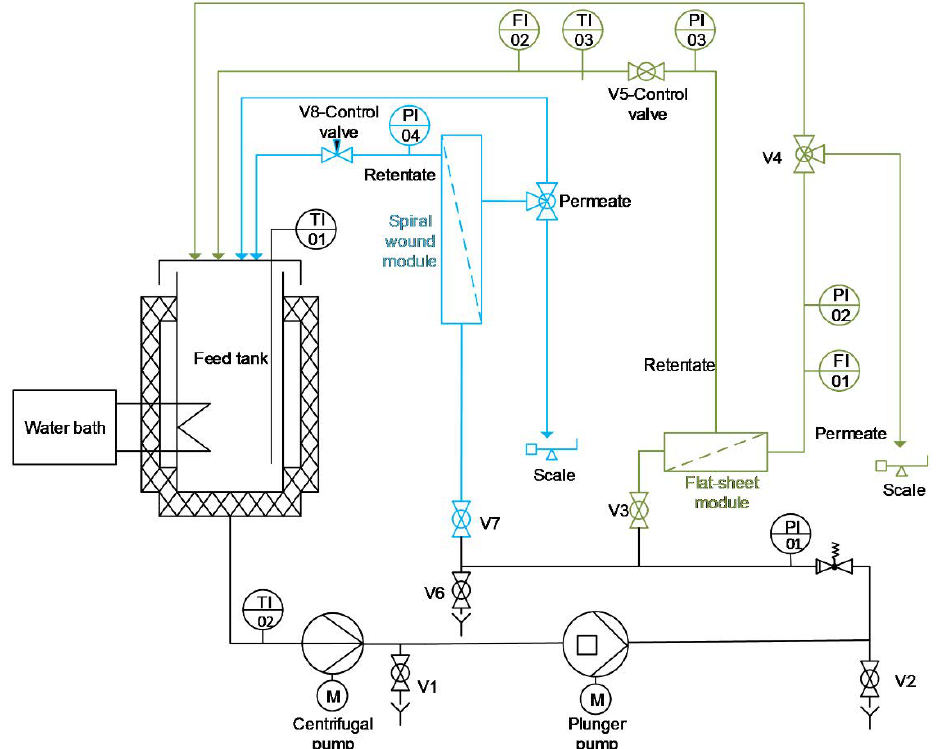
Figure 1. Piping and instrumentation diagram of filtration plant (green—flat-sheet module circuit; blue—1812 (cid:48)(cid:48) spiral wound module circuit).